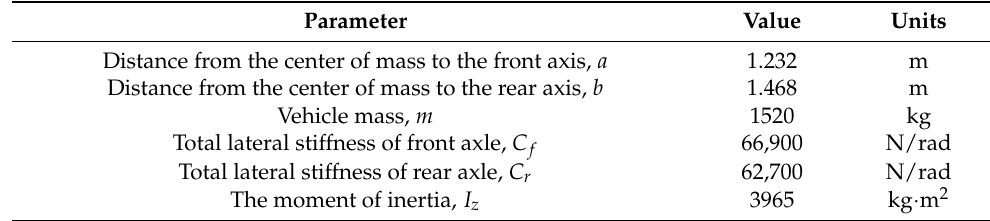
Table 5. Parameters of simulation vehicle.